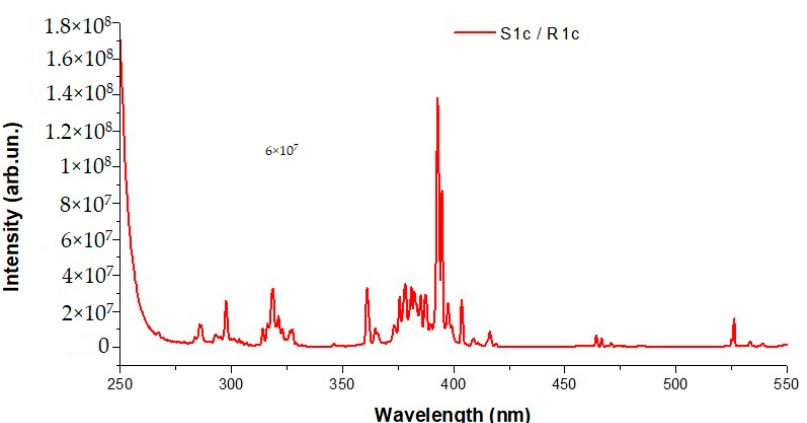
Figure 8. The PLE spectra of YAG:Eu (10%).